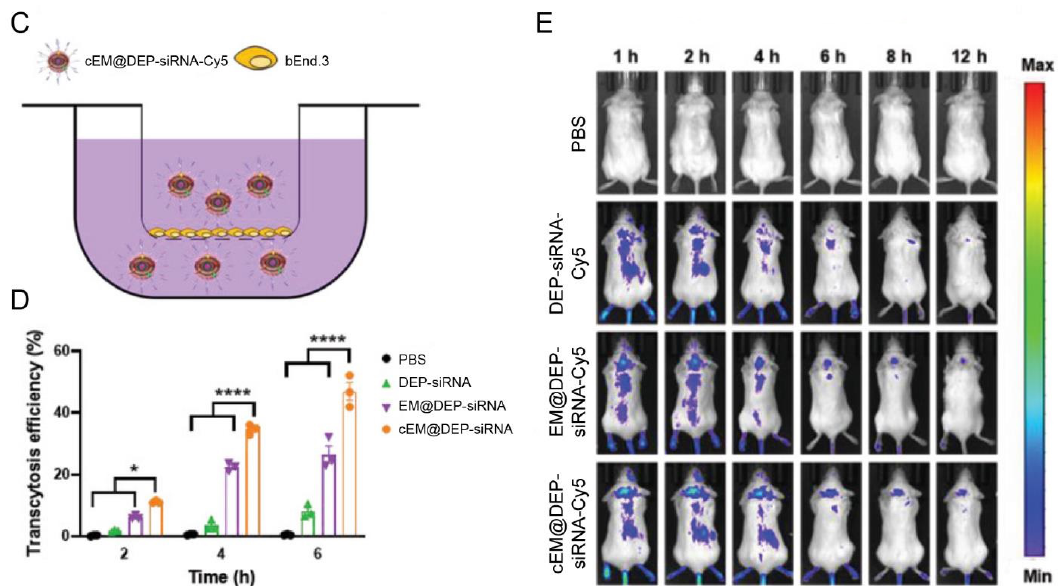
Figure 6. Macrophage-derived EVs for glioma therapy. ( A ) Schematic illustration of the process of exosome-based drug delivery system. ( B ) The cEM@DEP-siRNA penetrated the BBB and achieved tumor-targeting effects via tail injection. ( C ) Illustration of the in vitro BBB model. ( D ) Transcytosis efficiency of DEP-siRNA, EM@DEP-siRNA, and cEM@DEP-siRNA in the in vitro BBB model. ( E ) In vivo distribution of PBS, DEP-siRNA-Cy5, EM@DEPsiRNA-Cy5, and cEM@DEP-siRNA-Cy5 in orthotopic DIPG-bearing mice at 12 h postinjection. * p < 0.05, **** p < 0.0001, as assessed by one-way ANOVA. DEP, nanomicelles sealing panobinostat; PPM1D, protein phosphatase, magnesium-dependent 1, delta; EXO, exosome; cRGD, cRGD, cyclo (Arg-Gly-Asp-D-Tyr-Lys); cEXO, cRGD-functionalized EXO; EM, exosomal membranes from EXO; cEM, exosomal membranes from cEXO. Reprinted with permission from Ref. [92], © 2022 The Authors. Advanced Science published by Wiley-VCH GmbH.